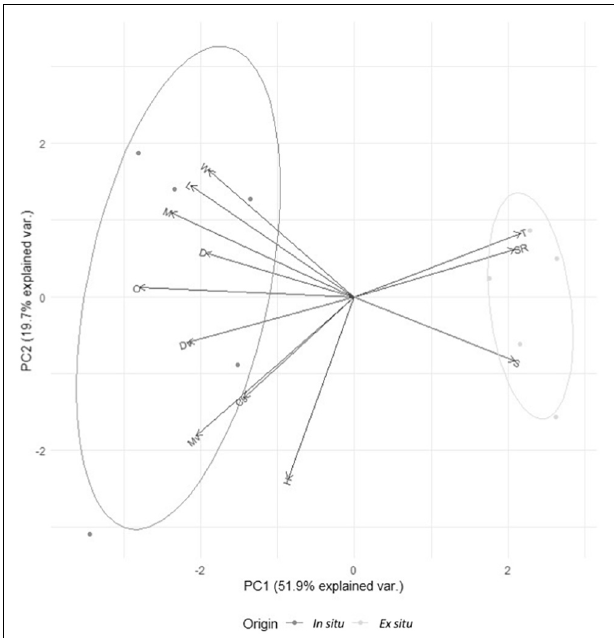
FIGURE 2 | Multivariate principal components analysis of developmental and abiotic variables from in situ ( n = 5, dark gray, left) vs. ex situ clutches ( n = 5, light gray, right). W, body weight/mass (gr); L, body length (mm); M, neuronal integration in the cellular layer of the medial cortex (number of NeuN + cells/mm); D, neuronal integration in the cellular layer of the dorsomedial cortex (number of NeuN + cells/mm); O, cell proliferation in the ovary (number of BrdU + cells/mm); Dv, cell proliferation in the dorsal ventricular zone (number of BrdU + cells/mm); Mv, cell proliferation in the medial ventricular zone (number of BrdU + cells/mm); Cs, coarse sand (proportion); H, humidty (proportion); T, temperature ( ◦ C); SR,